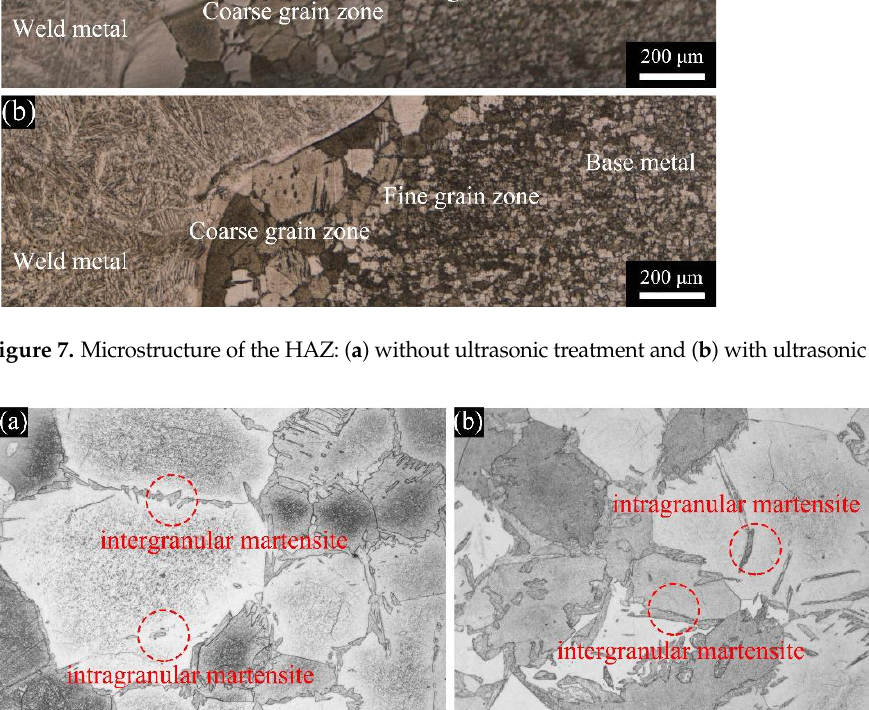
Figure 7. Microstructure of the HAZ: ( a ) without ultrasonic treatment and ( b ) with ultrasonic treat- ment.